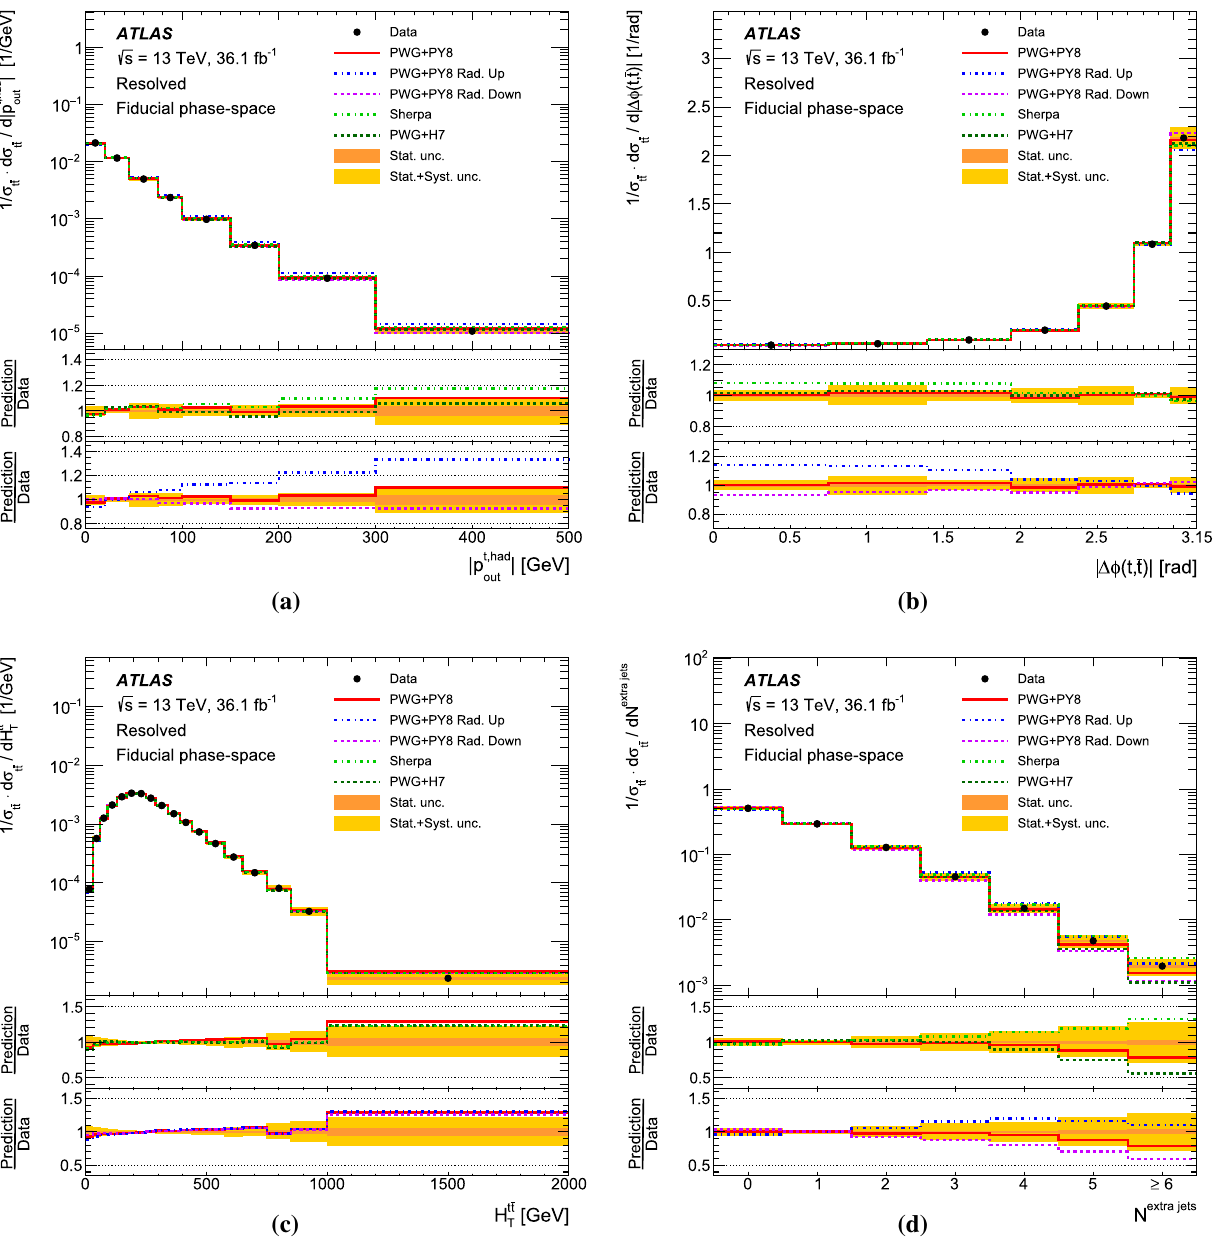
Fig. 25 Particle-level normalised differential cross-sections as a func- (cid:7) (cid:7) (cid:7) (cid:5)(cid:7) (cid:4) (cid:7) (cid:7) (cid:7) (cid:8)φ (cid:7) , c H t ¯ t (cid:7) , b (cid:7) p t , had t , ¯ t tion of a and d additional jet multiplicity out T in the resolved topology, compared with different Monte Carlo predic-